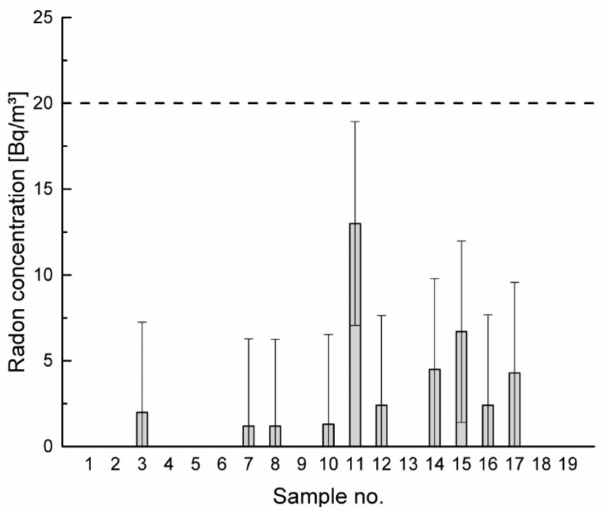
Figure 5. Measured radon concentrations of samples foremostly containing earthen